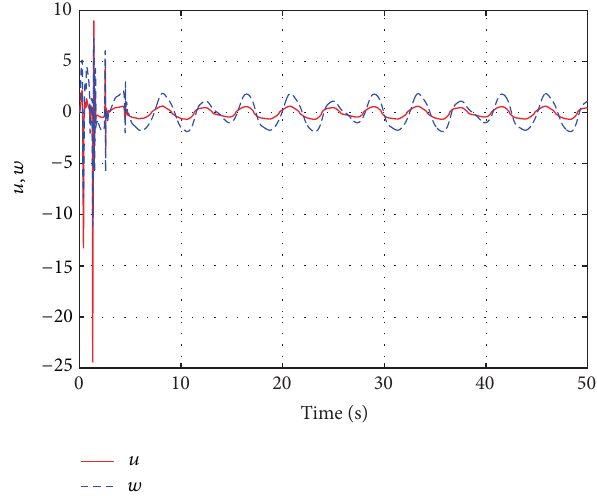
Figure5:Controlinput 𝑢 (realline)andhysteresisoutput 𝑤 (dashed line).